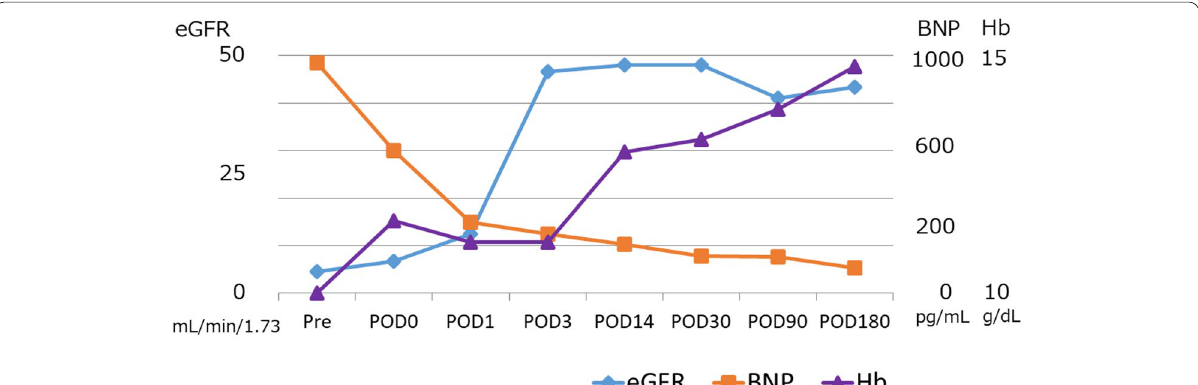
Fig. 1 Changes in the perioperative cardiac and renal function; the patients’ cardiac and renal function, and anemia improved greatly. BNP, brain natriuretic peptide; eGFR, estimated glomerular filtration rate; Hb, hemoglobin; POD, postoperative day